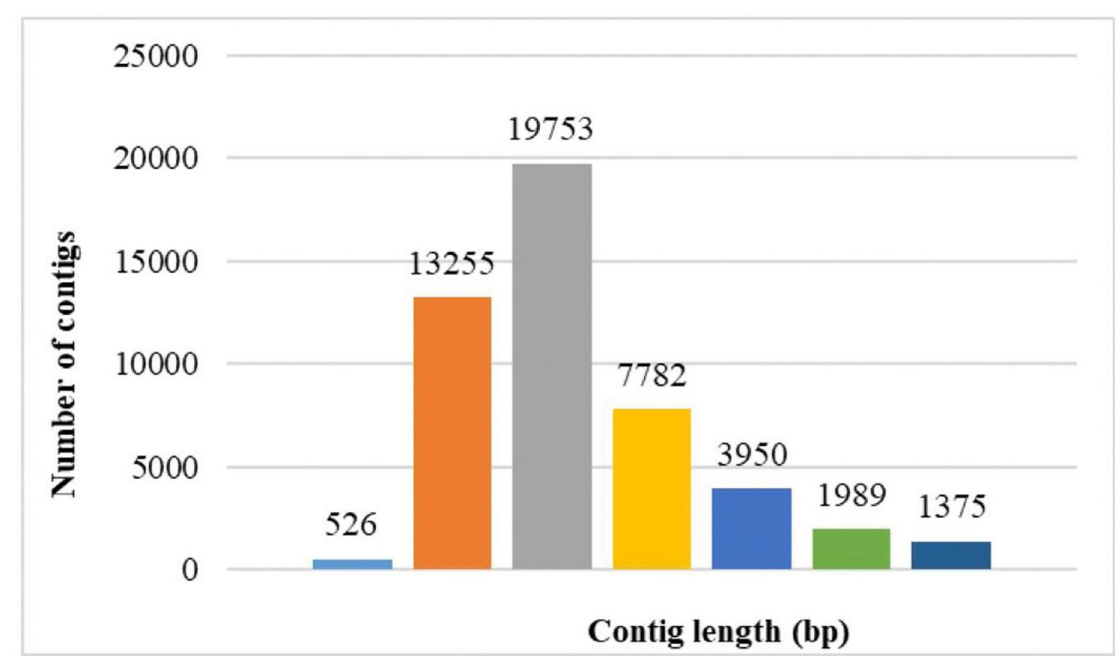
Fig 1. The size distribution of the contigs obtained from de novo assembly of L . tridentata